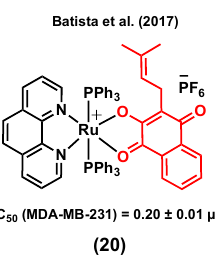
Figure 8. A ruthenium complex bearing